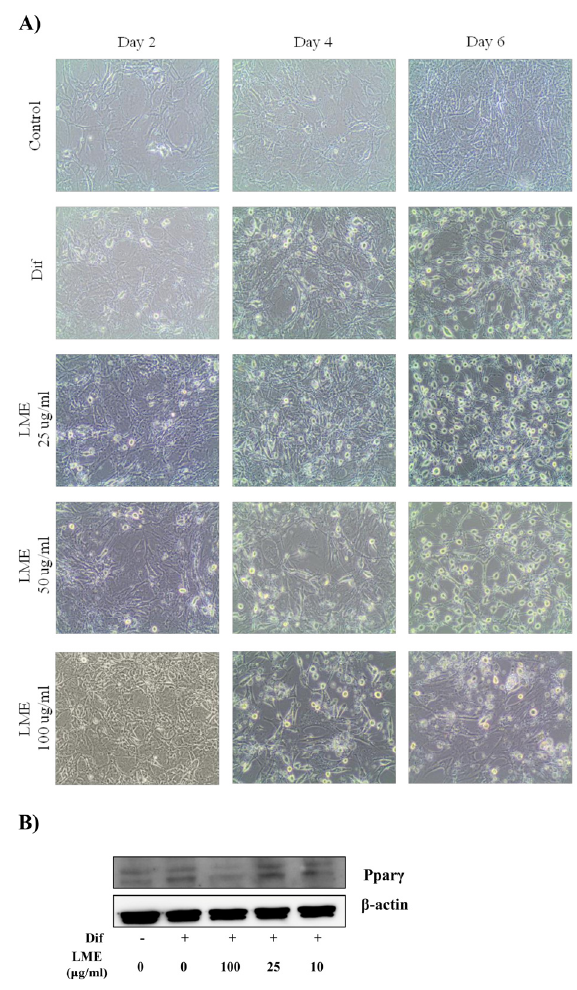
Figure 4. ( A ) Effects of LME (10–100 µ g/mL) on adipogenesis (bright cells indicate the presence of lipid accumulation) as well as ( B ) PPAR γ protein levels in 3T3-L1 cells. The experiments were performed three times.